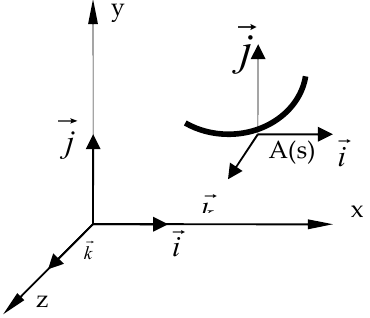
Figure 3. A spring element with axes and unit vectors.